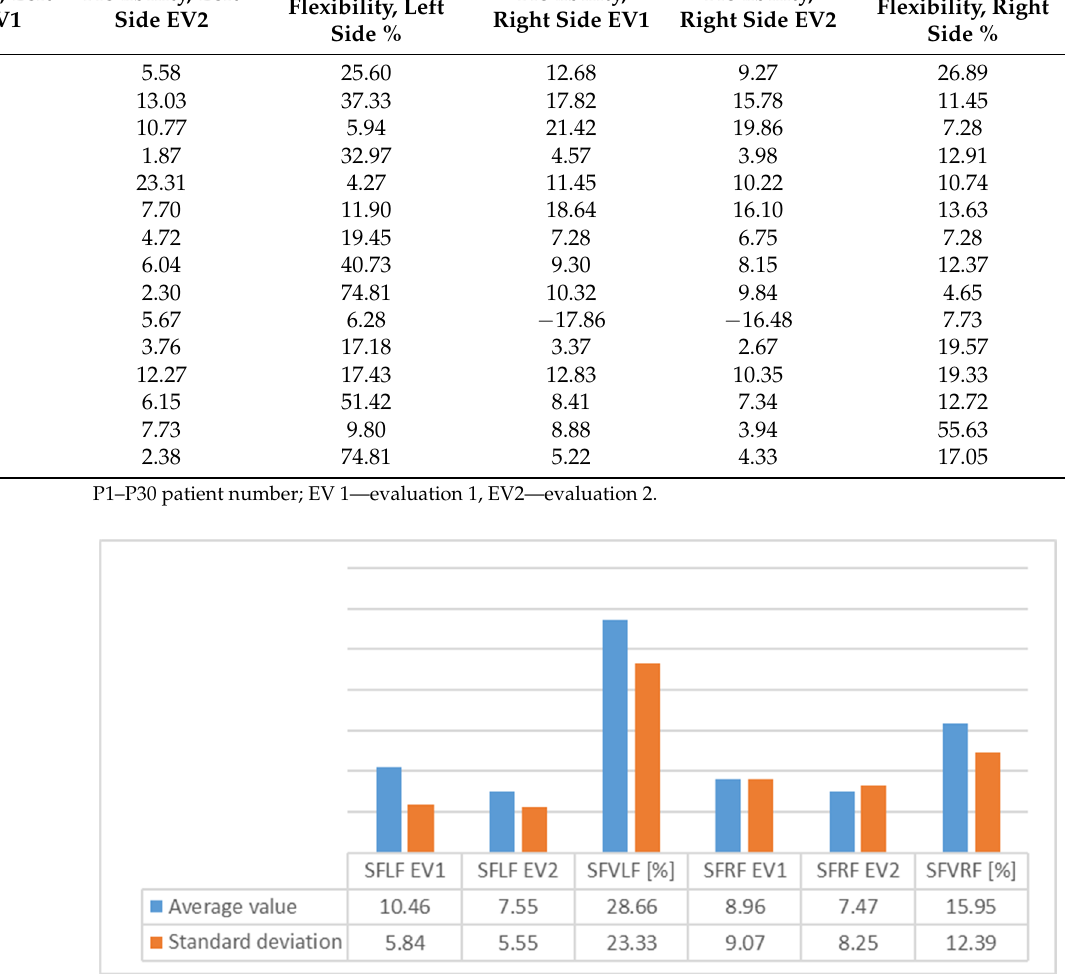
Figure 3. Variation of average values and standard deviation for subtalar flexibility for Group 1 between EV1 and EV2 (SFLF = subtalar flexibility for left foot; SFVLF = subtalar flexibility variation for left foot; SFRF = subtalar flexibility for right foot; SFVRF = subtalar flexibility variation for right foot).